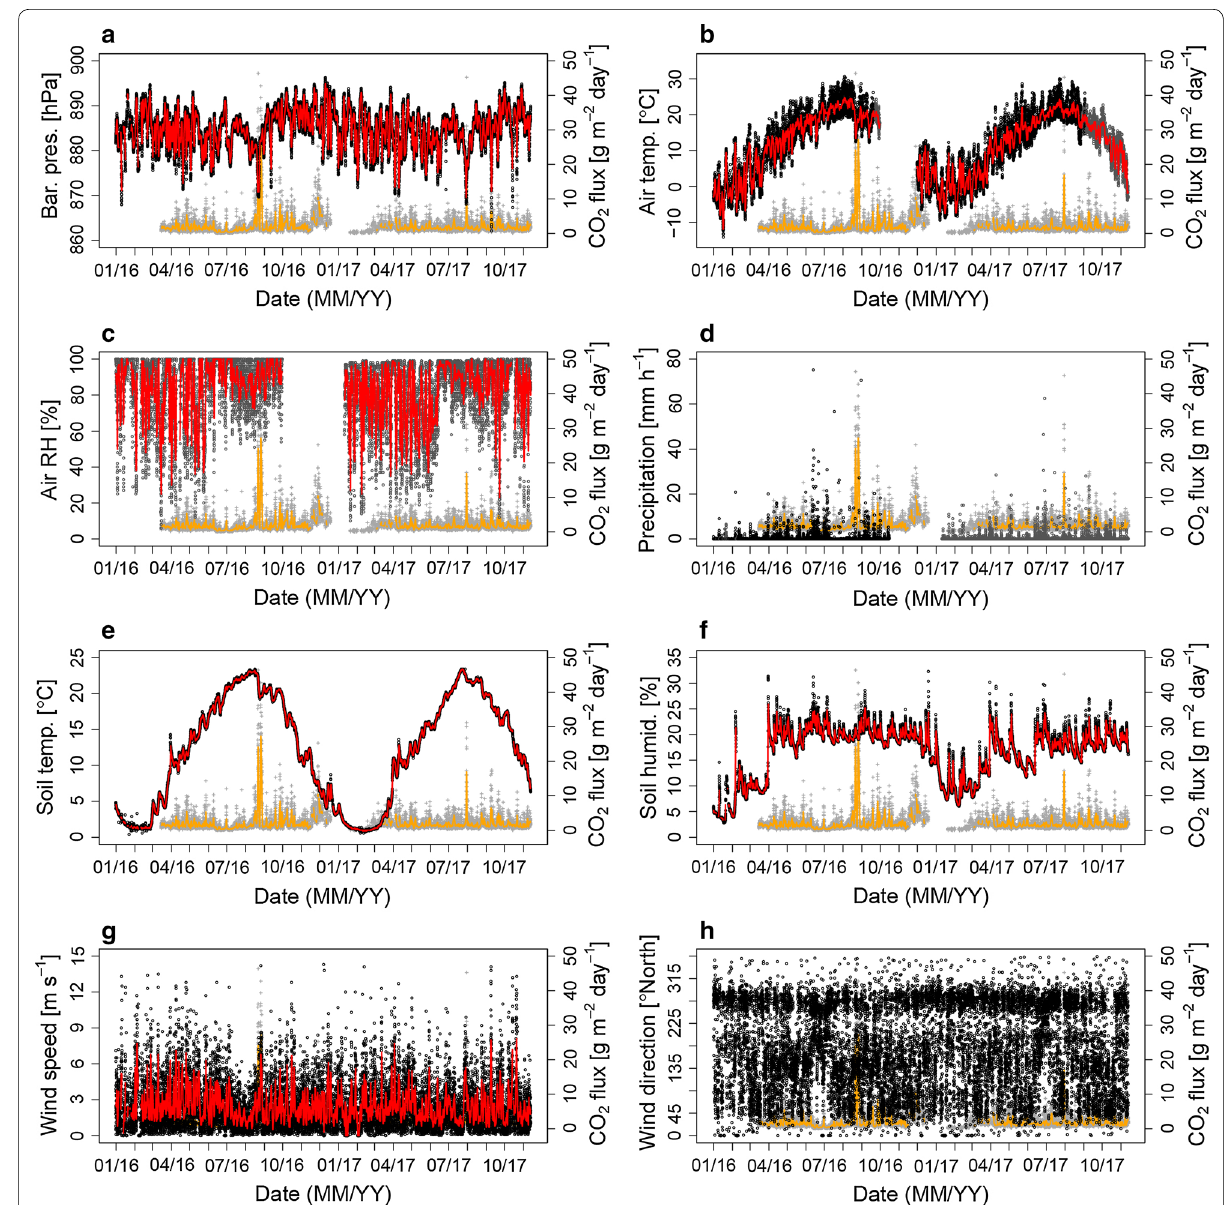
Fig. 4 Time series of environmental parameters from January 2016 to November 2017 for a barometric pressure, b air temperature, c air relative humidity, d precipitation, e soil temperature, f soil humidity, g wind speed, and h wind direction. The black and dark gray circles correspond to data obtained at the soil CO 2 flux station and those obtained at the weather station, respectively. The red line shows the daily average values of the data. The gray crosses and orange dotted line correspond to soil CO 2 flux and its daily average values shown in Fig. 3,